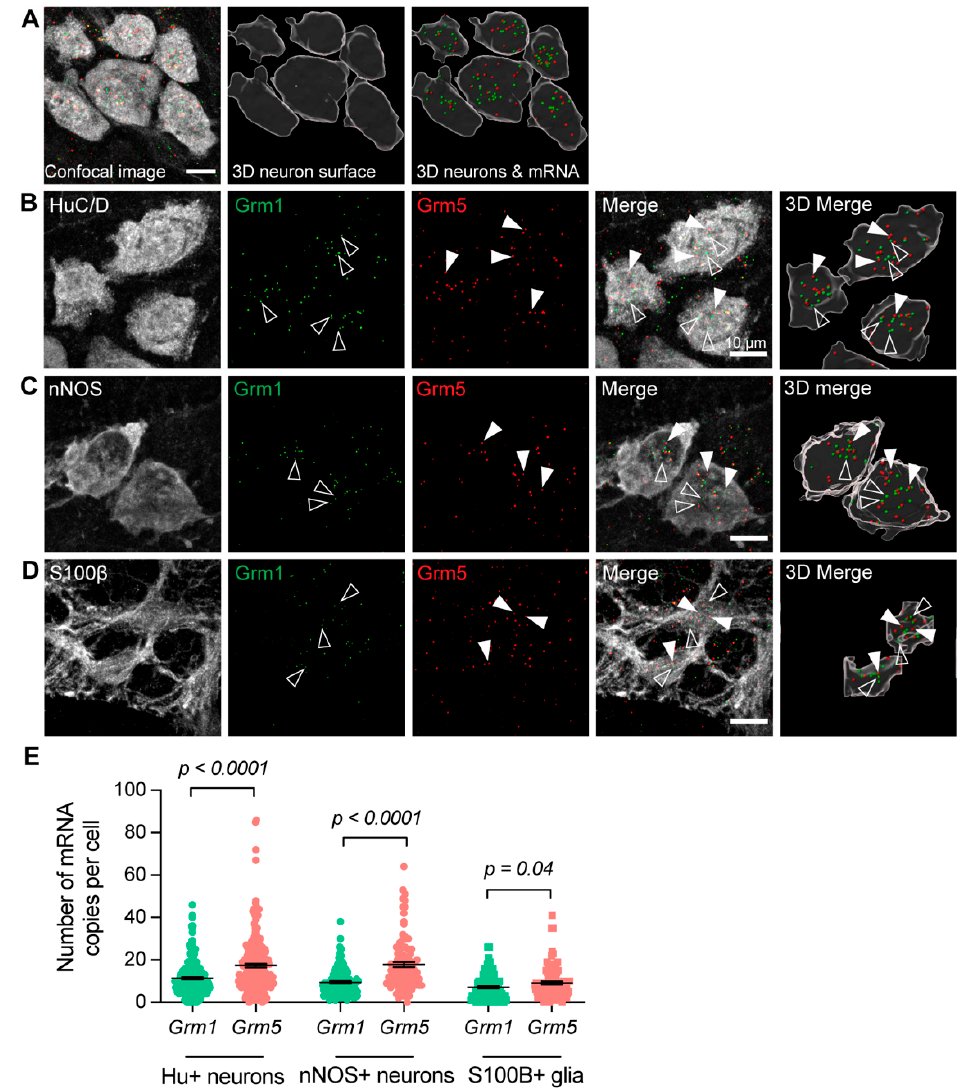
Figure 2. Expression of Grm1 and Grm5 in the myenteric plexus of the mouse mid colon. ( A ) Representative images showing an original confocal micrograph of HuC/D+ (Hu+) neurons together with Grm1 (green) and Grm5 (red) mRNA signals (left), 3D-rendered surfaces of the Hu+ neurons (middle), and 3D-rendered surfaces of Grm1 and Grm5 mRNA signals together with Hu+ neurons (right). Each spot depicts a single mRNA transcript of Grm1 (arrow) and Grm5 (open arrow). ( B – D ) Panels showing Grm1 and Grm5 expression in Hu+ neurons ( B ), nNOS+ neurons ( C ), and S100B+ glia ( D ). In each panel, the confocal micrographs of the immunofluorescent signals are shown on the left, with the 3D-rendered cells on the right. Grm1 transcripts are indicated by open triangles, and Grm5 transcripts by closed triangles. ( E ) Average number of individual mRNA for Grm1 and Grm5 in Hu+ neurons, nNOS+ neurons, and S100 β + glia. 197/202 (98%) Hu+ neurons expressed Grm1 (11.4 ± 0.6 Grm1 mRNA copies per Hu+ neuron, N = 3 mice), and 200/202 (99%) of Hu+ neurons expressed Grm5 (17.4 ± 0.9 Grm5 mRNA copies per Hu+ neuron, N = 3 mice). All 104 nNOS+ neurons analyzed contained Grm1 (9.4 ± 0.6 Grm1 mRNA copies per nNOS+ neuron), and 103/104 (99%) contained Grm5 (17.9 ± 1.2 Grm5 mRNA copies per nNOS+ neuron, N = 3 mice). 87/96 (91%) S100 β + glia expressed Grm1 (7.2 ± 0.6 Grm1 mRNA copies per S100 β + glia, N = 3) and 91/96 (95%) S100 β + glia expressed Grm5 (9.2 ± 0.8 Grm5 mRNA copies per S100 β + glia, N = 3). Student’s t -test.